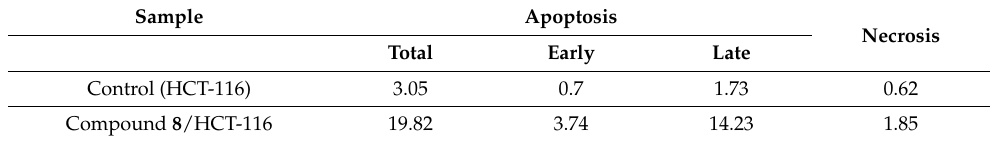
Table 5. Stages of cell death in HCT-116 cells after exposure to compound 8 (5.4 µ M) for 24 h.